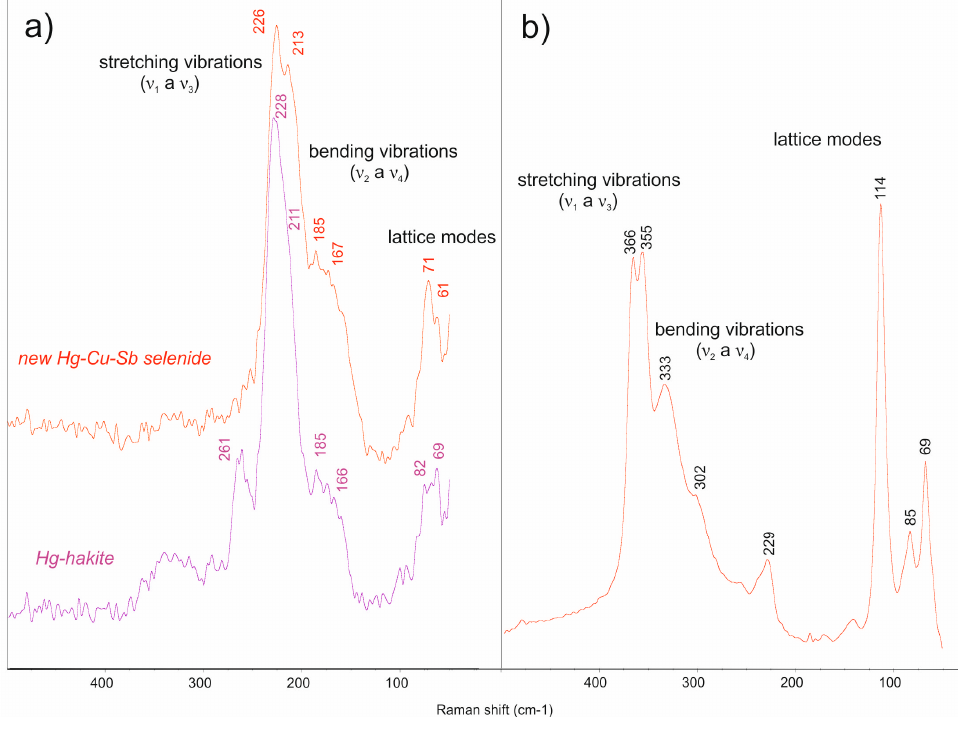
Figure 64. Raman spectra of ( a ) the new Hg-Cu-Sb selenide and Hg-hakite and ( b ) coexisting tetrahedrite. The vertical shift of spectra was done for clarity.